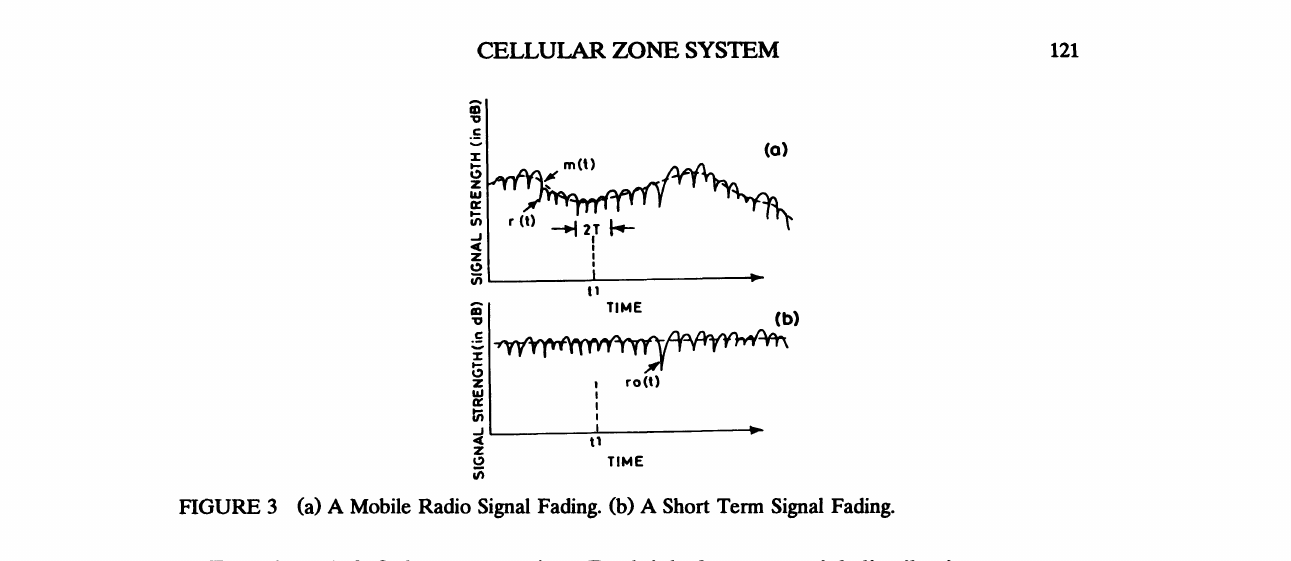
(a) A Mobile Radio Signal Fading. (b) A Short Term Signal Fading. FIGURE 3 Equations 1 & 2 degenerates into Rayleigh & exponential